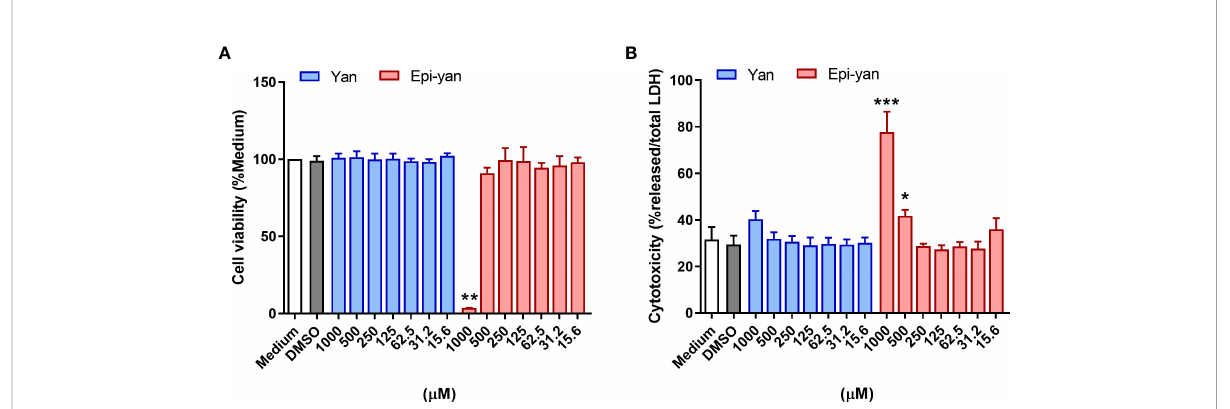
FIGURE 2 Cytotoxicity of yangambin and epi-yangambin. The cytotoxic potential of both lignans was assessed by (A) Sodium resazurin reduction assay and (B) total LDH release after 48 h of treatment at varying concentrations (1000 - 15.6 µM). Bars represent ± SD of one representative experiment, from three independent experiments performed in quintuplicate. The Kruskal-Wallis test, followed by Dunn ’ s post-test, was used for multiple comparisons (*p<0.05, **p<0.01 and ***p<0.0001). Yan, yangambin; Epi-yan, epi-yangambin.